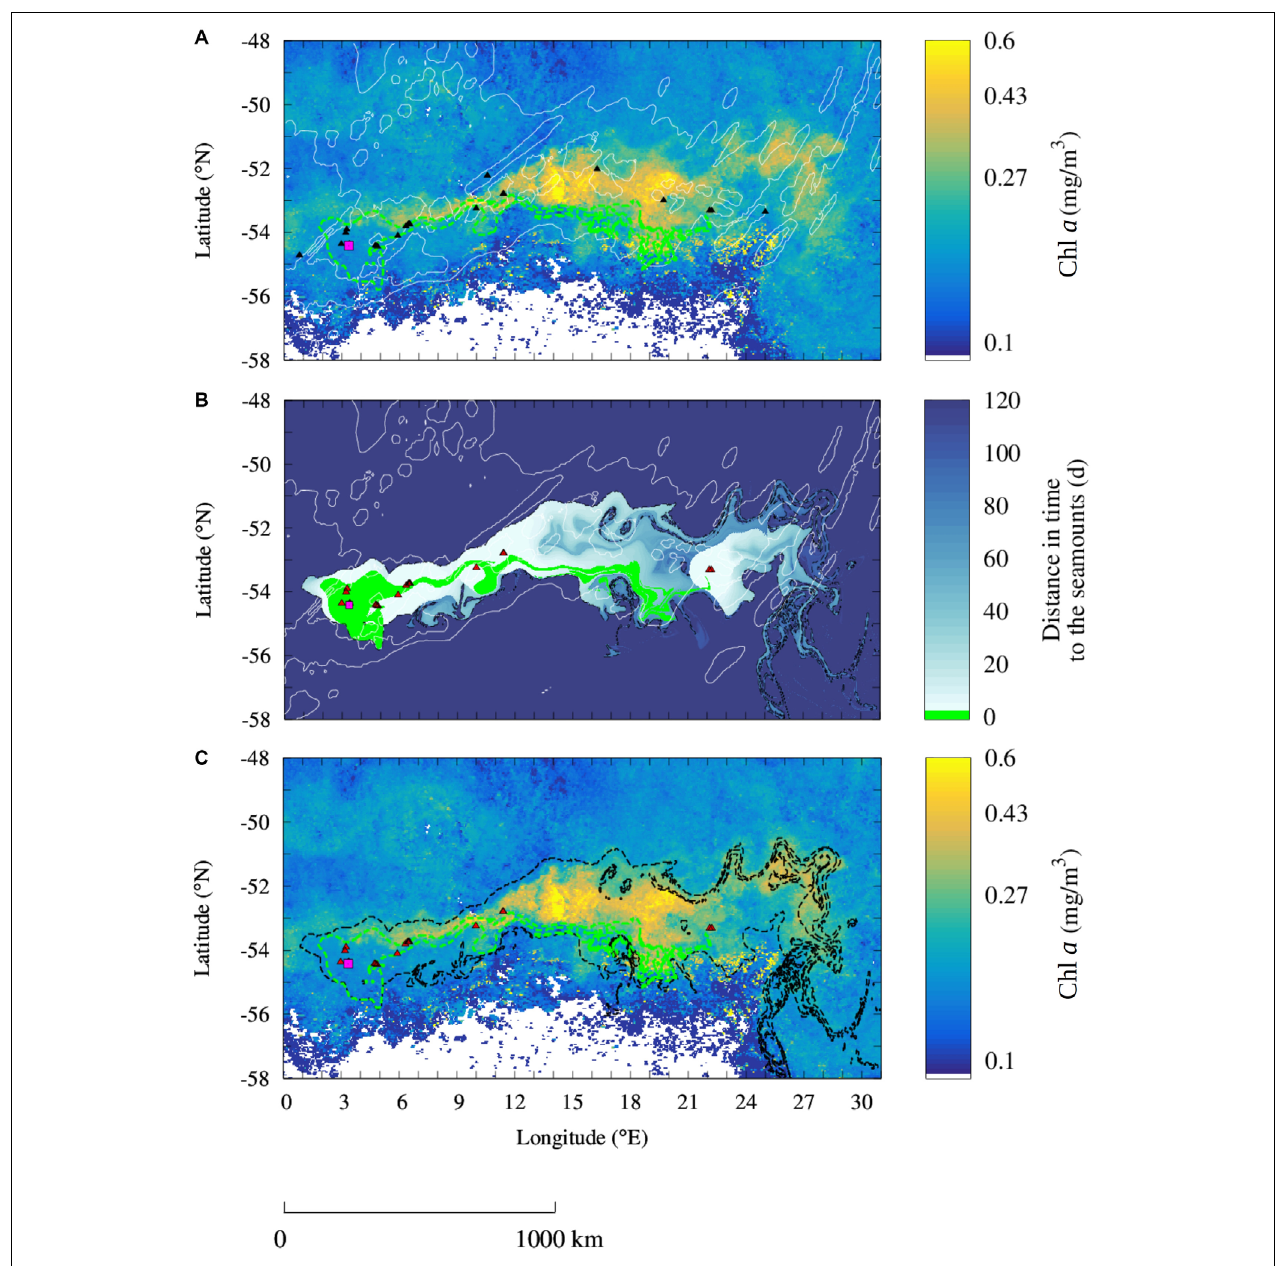
FIGURE 4 | Observation of seamount mass effect from the SWIR complex. (A) Observation of a Chl a plume downstream of the shallow seamounts of the SWIR (black triangles) in October 2002. (B) Reconstruction of the Lagrangian plume from the seamount of the SWIR selected for the study period (red triangles). Black contours indicate the water masses that have been in contact in the 100 days before the bloom event with the selected seamounts. (C) Comparison of the Chl a plume observed in the monthly-mean composite image with the Lagrangian plume estimated from altimetry [black contour extracted from panel (B) ]. The Lagrangian plume stemming from Bouvet Island (magenta square) and computed over the 4 months before the bloom is overlapped in all the panels [green contours in panels (A,C) and green area in panel (B)] . Shallow seamounts identified at the study period for the Lagrangian analysis are shown in red (B,C) . Isobaths of bottom topography of 3000 and 4100 m depths are shown in white (B,C) . Note the logarithmic scale for the Chl a images. Whites areas in Chl a images (A,C) correspond to unidentified